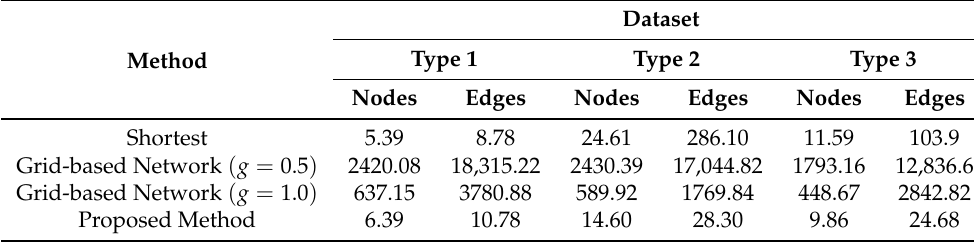
Table 10. Average graph size for the route planning